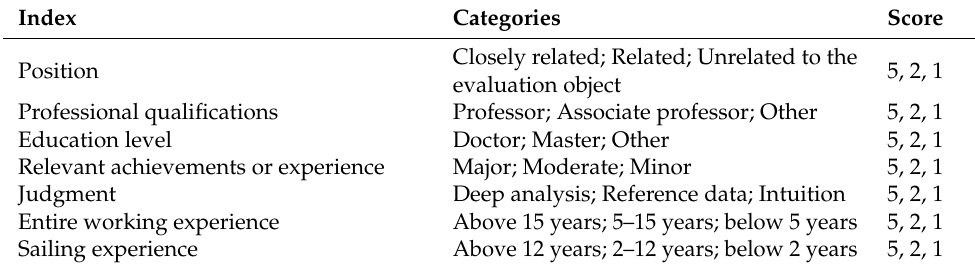
Table 4. Expert scoring